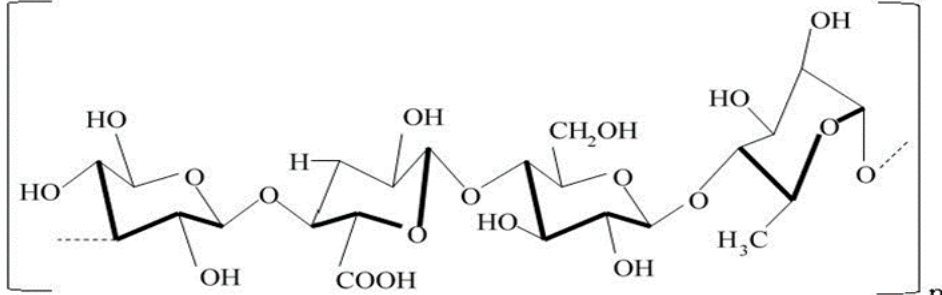
Figure 1. The structure of gellan involves tetrasaccharide repeating units consisting of two molecules of D -glucose as well as one molecule each of L -rhamnose and D -glucuronic acid.